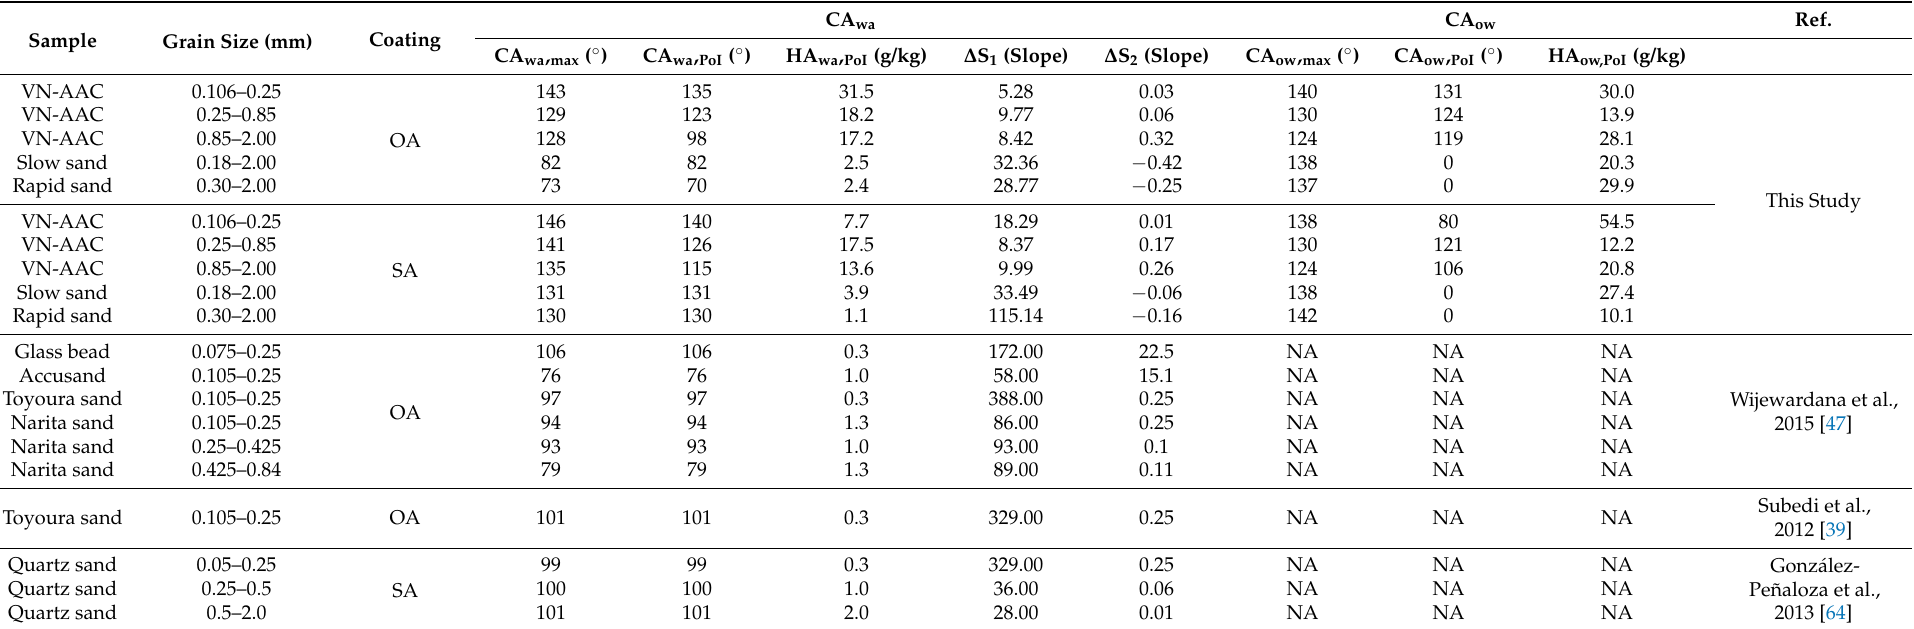
Table 2. Summary of hydrophobicity/oleophilic parameters in this study and the